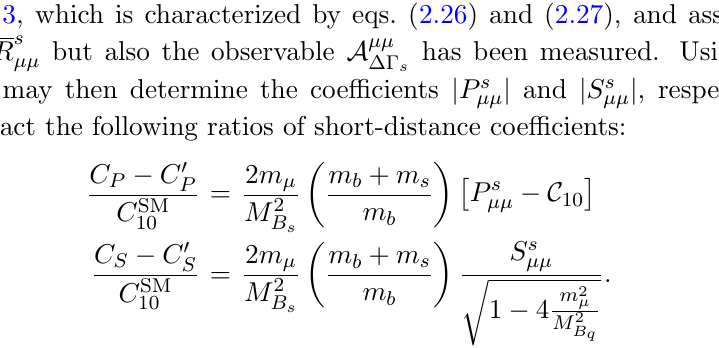
= 1. We show C 10 s in eq. (3.12), which is described by the (cid:22)(cid:22) (cid:22)(cid:22) (cid:1)(cid:0) s A